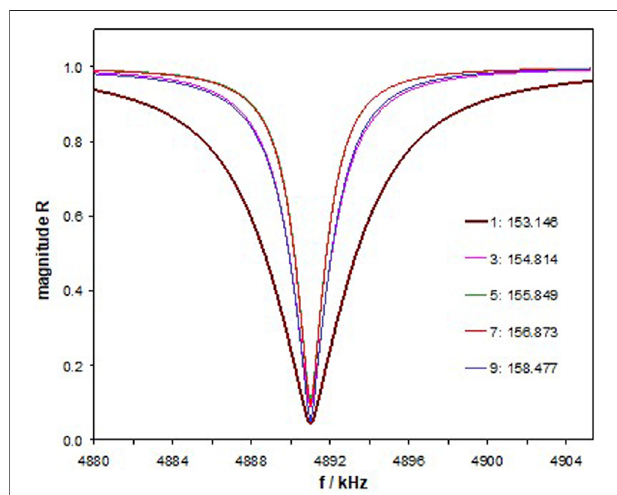
FIGURE 6 | Magnitude of R for the xPnC with a modi fi ed analyte layer thicknesstorealizethesame f res .Therespectivethicknesses(inµm)arenoted in the legend (inside the